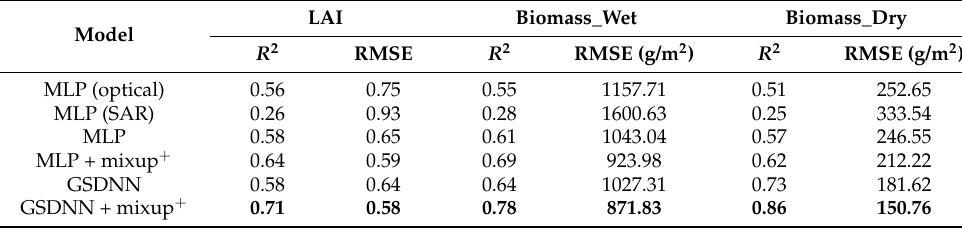
Table 5. Comparison of results between different deep learning models.